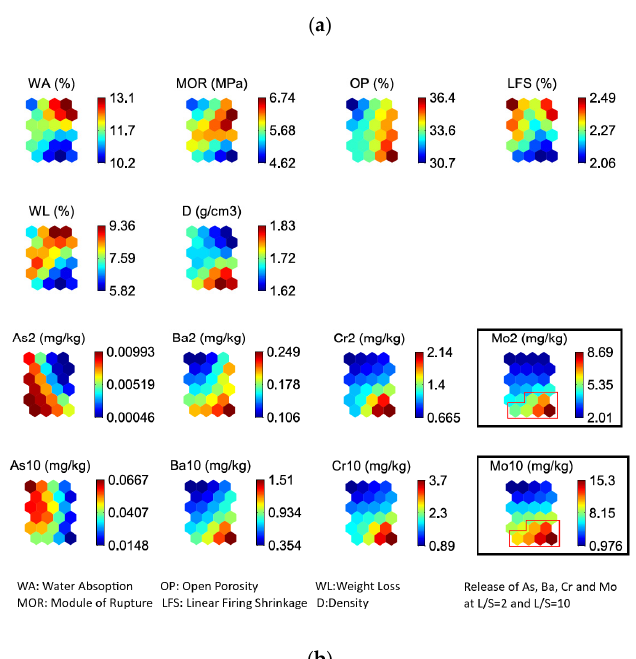
Figure 4. ( a ) Clustered map with labels of the studied pilot-plant clay mixtures with WS-FSD incorporation. The four clusters (I–IV) have been derived from the k-means algorithm applied to the trained SOM. The labels in the hexagons of the map show the BMU corresponding to each sample. ( b ) Component planes of the SOM for the 14 input variables with Mo highlighted along with neurons that exceed non-hazardous landfill limits. Each map corresponding to one variable (component) should be compared to the map representing the distribution of the pilot-plant clay mixtures with WS-FSD incorporation presented in Figure 4a; hexagons in the same place on different component planes correspond to the same map unit. The colours indicate the value of the component in the weight vector of each unit of the map, according to the colour bars on the right.